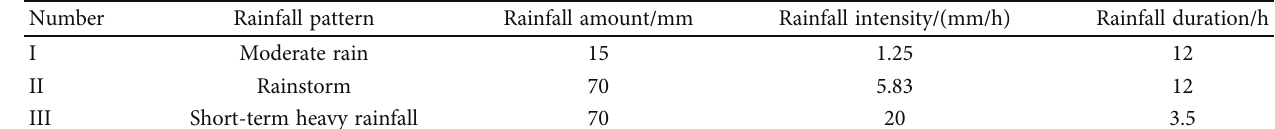
Table 1: Rainfall scheme.